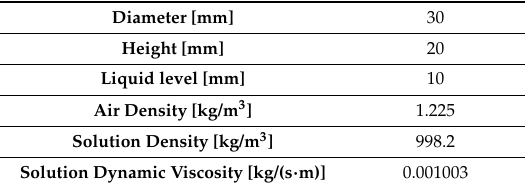
Table 2. Properties of the container domain.